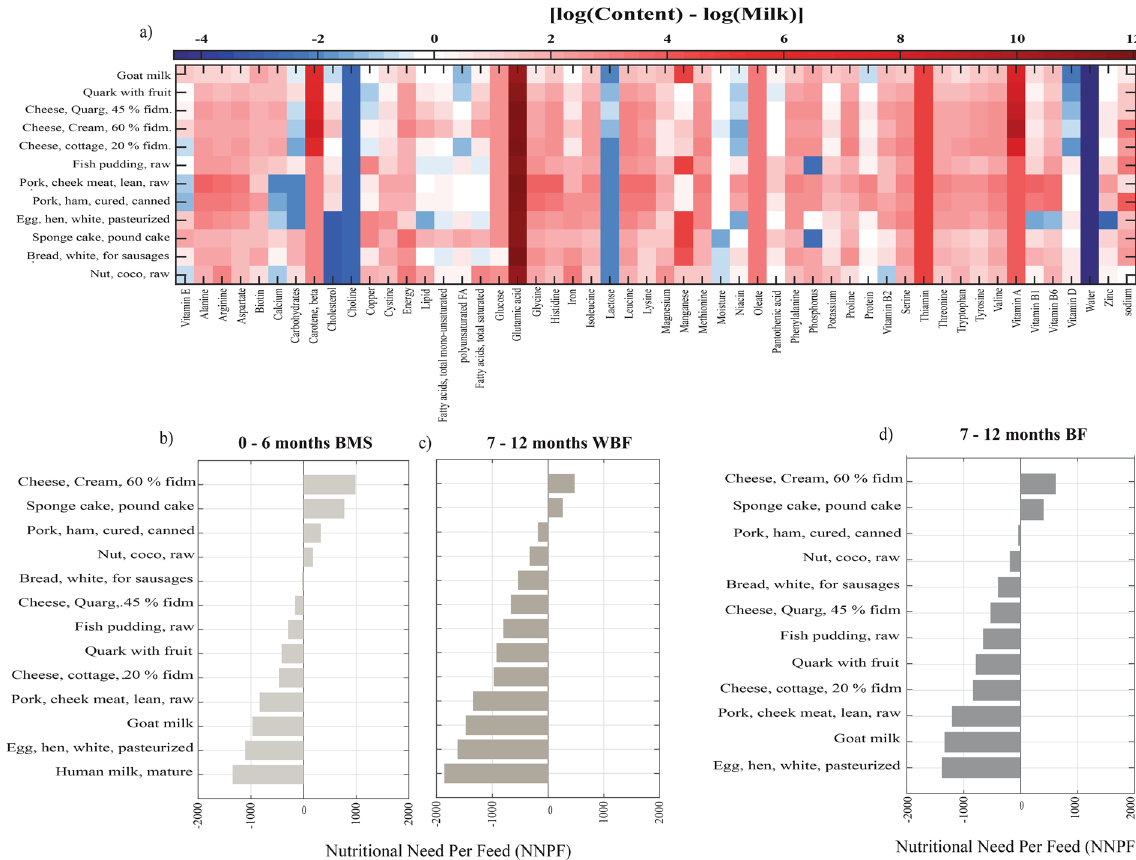
Figure 3. ( a ) Fold change in concentration of food constituents expressed in mg/100 g with respect to human milk. ( b ) Nutritional Need Per Feed (NNPF) scores of these foods when given to 0–6 months’ infants as breast milk substitutes (BMS). ( c ) NNPF scores of foods when given to 7–12 months infants as substitutes without breast feeding (WBF). ( d ) NNPF scores of foods when given to 7–12 months’ infants as complementary foods (with breast feeding,